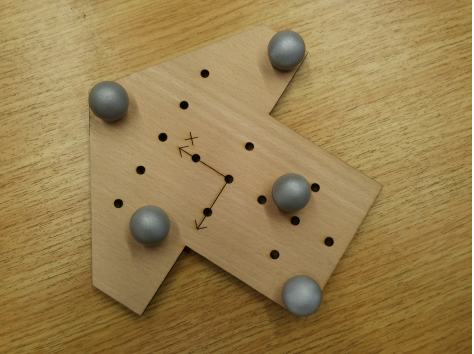
Figure 11. MoCap marker set used on the human targets and the robots to measure their true position in the